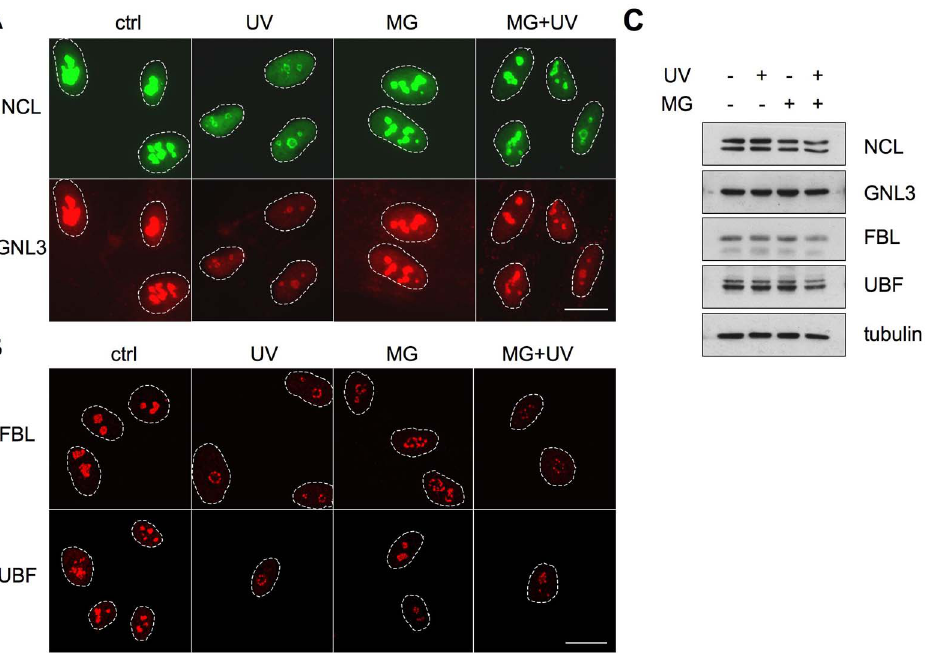
Figure 4. Nucleolar protein UV responses and proteasome inhibition are divergent and depend on the nucleolar subcompartment. WS1 cells were pretreated with MG132 followed by UV radiation (35 J/m 2 ) as shown. Cells were fixed after 3 hours and stained for NCL and GNL3 ( A ), or FBL and UBF ( B ). Confocal images are shown for FBL and UBF ( B ). Scale bar 20 m m. C Western blotting analysis for the respective proteins. Equal amounts of total protein were separated by SDS-PAGE and immunoblotted for NCL, GNL3, FBL and UBF. Tubulin was used as a loading